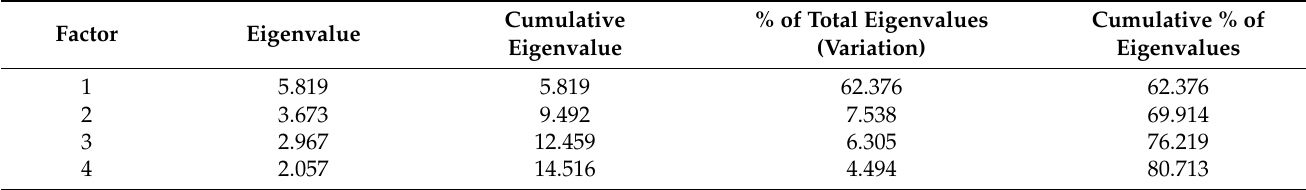
Table 2. Hierarchy of factors according to their eigenvalues based on the Kaiser criterion (for the total of respondents). Factor